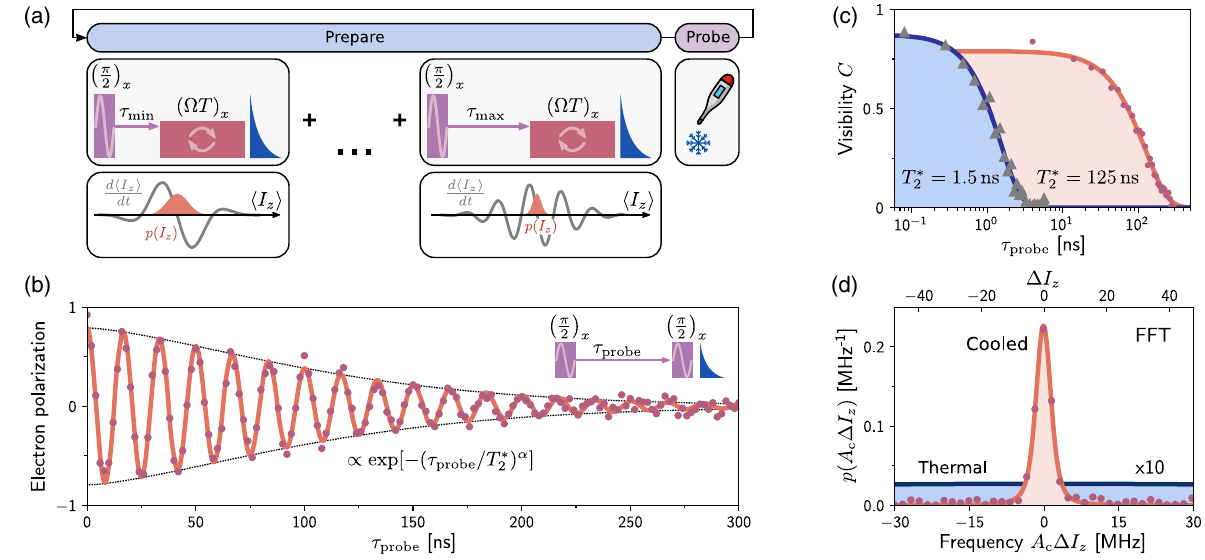
FIG. 2. Optimal feedback algorithm. (a) Feedback control sequence. We use 44 elementary blocks of the algorithm. Each block has an R π = 2 Þ rotation to initiate sensing (purple), an R Ω T Þ pulse to actuate a spin flip via a HH resonance (red), and optical pumping for x ð x ð electron reset (blue). The sensing time is increased linearly over the 44 blocks from τ to τ , resulting in the schematic feedback min max 30 ns, curves (gray) beneath. (b) Electronic FID under optimal feedback. We alternate ∼ 15 μ s of feedback — where τ min ¼ τ 98 ns, Ω ¼ 29 MHz, and T ¼ 86 ns — with ∼ 2 μ s of probing p ð Δ I z Þ via Ramsey interferometry (inset), yielding a 60 kHz max ¼ repetition rate for single shots of the experiment. Each data point is an ensemble average measurement integrated for 2 sec. The purple 60 MHz set by the phase, circles are the FID h S z ð τ as a function of Ramsey delay τ . The FID oscillates at a frequency ω probe Þi probe serr ¼ τ 2 πω , which we add to the second Ramsey gate to make the process of fitting the envelope robust against small systematic serr probe α (cid:2) (dotted curve), where =T (cid:4) detunings. The red curve is a phenomenological fit to a cosine with envelope C ð τ exp ½ − ð τ 2 Þ probe Þ ¼ probe T (cid:4) 125 ð 4 Þ ns and α ¼ 1 . 46 ð 9 Þ . (c) Triangles (circles) are the FID envelopes resulting from a nuclear-spin ensemble without (with) the 2 ¼ application of our optimized feedback algorithm. Fitting these data with the blue and red C ð τ curves yields T (cid:4) 2 ¼ 1 . 52 ð 5 Þ ns, probe Þ α ¼ 1 . 60 ð 12 Þ and T (cid:4) 125 ð 4 Þ ns, α ¼ 1 . 46 ð 9 Þ , respectively. (d) Fourier transform of data (circles) and FID envelopes (curves) from 2 ¼ Δ I Fig. 2(c), yielding explicitly the probability distribution p ð A z Þ for the purified (thermal) ensemble shown in red c